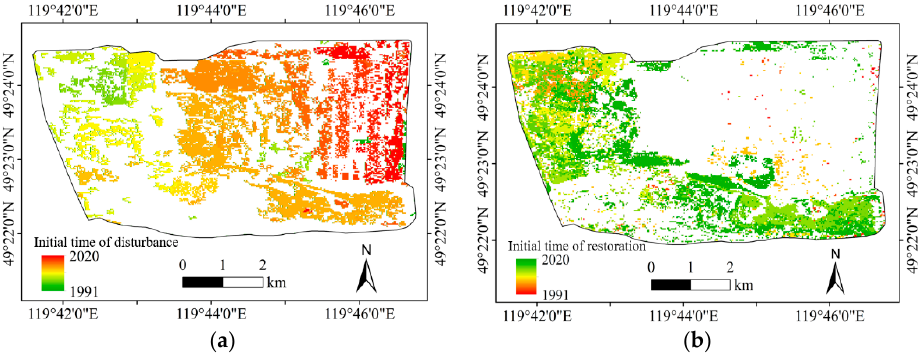
Figure 8. Initial time of vegetation disturbance and restoration. ( a ) Initial time of disturbance; ( b ) Initial time of restoration.